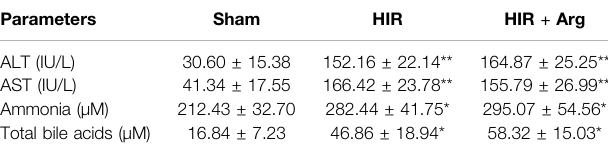
TABLE 2 | Biochemical parameters related to liver function in serum of sham- operated (Sham) and hepatic ischemia-reperfusion (HIR) (1 h ischemia and 24 h reperfusion) rats and HIR rats orally supplemented with Arg (0.18 g/kg) before surgery and at 2, 6, and 12 h of reperfusion (HIR + Arg) ( n (cid:2) 6).